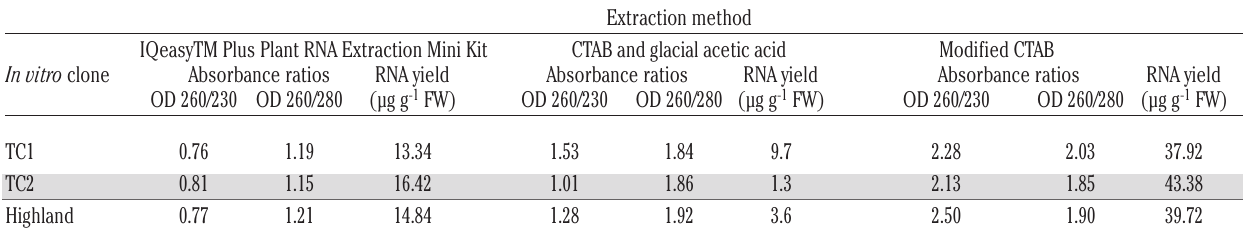
Table 1. Yield of RNA and absorbance ratios from three different clones for three different methods of total RNA